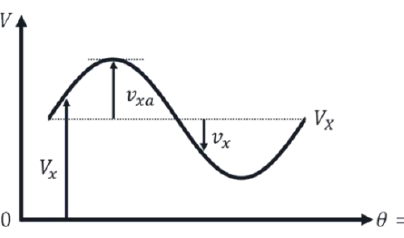
Figure 5. Notation of voltages in this work.